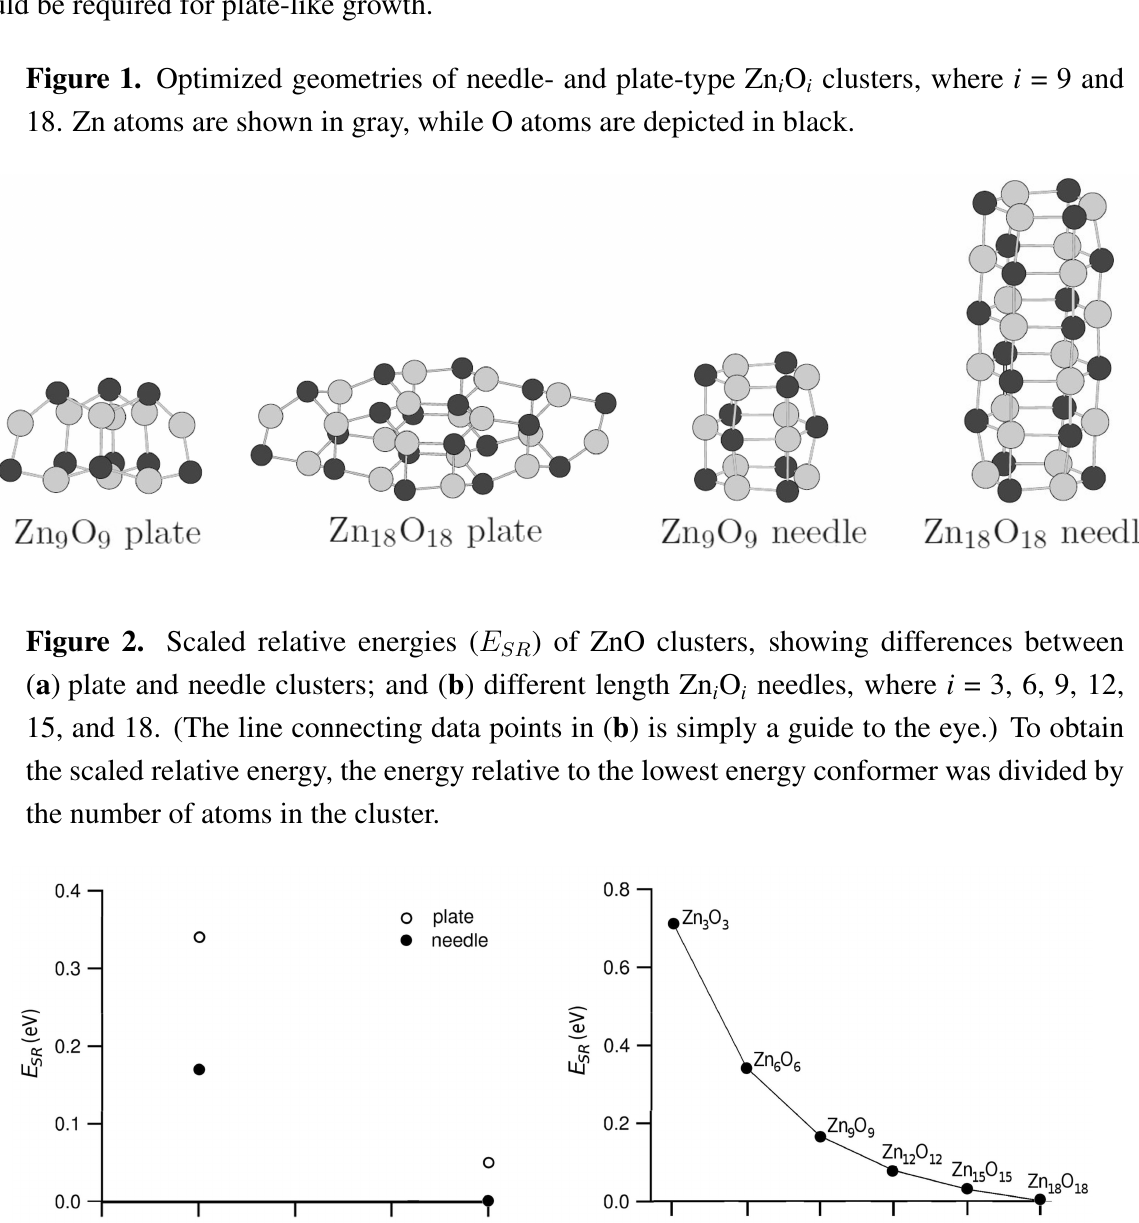
O clusters, where i = 9 and i i